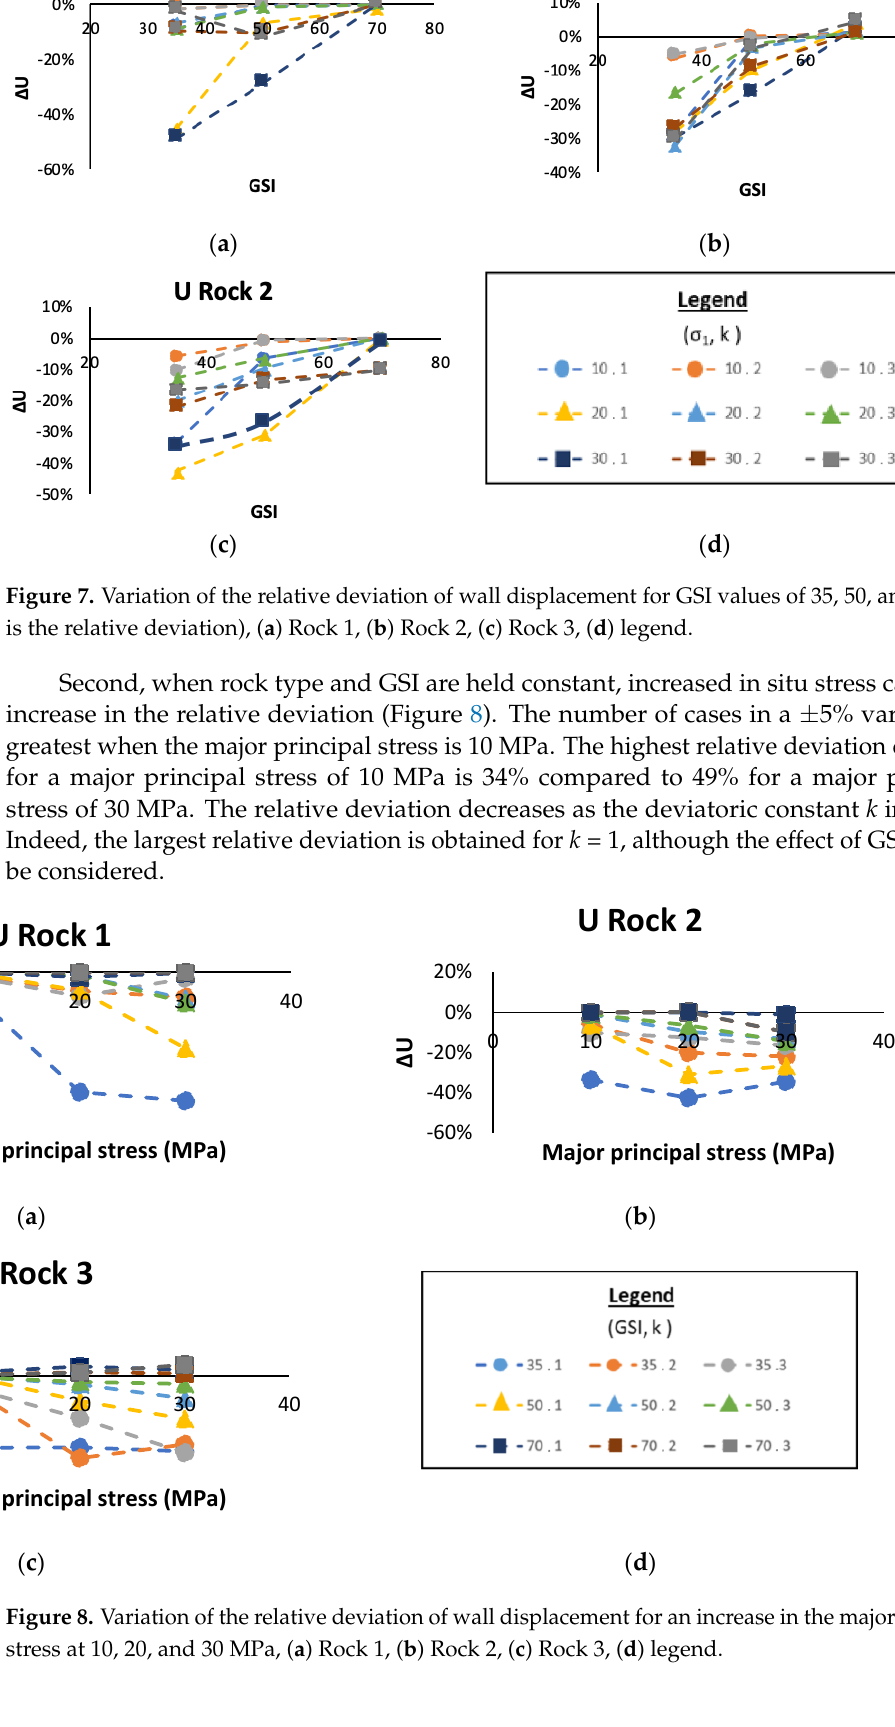
ation obtained for a GSI of 35 to 50 is greater than a GSI between 50 and 70.